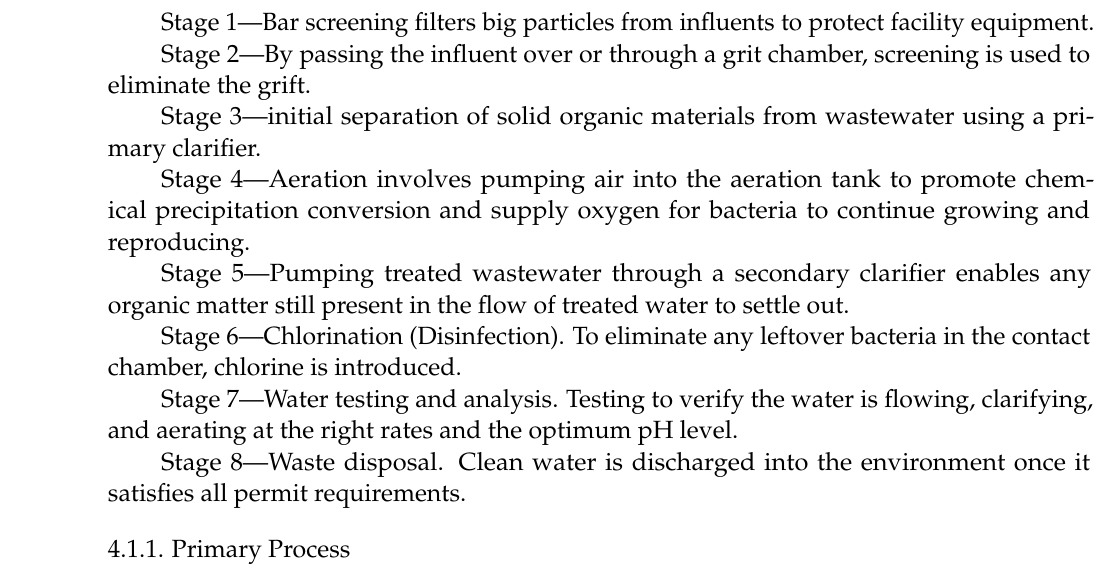
Figure 3. Eight Stages of the Wastewater Process. Stage 1—Bar screening filters big particles from influents to protect facility